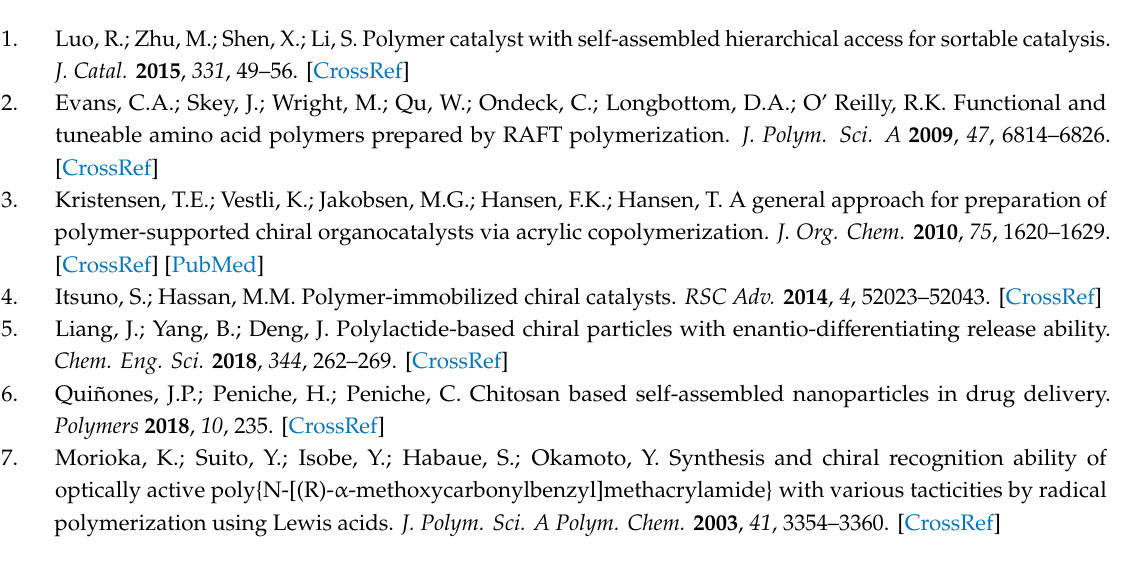
(penetration depth 1.66 mm). Figure S3: Phase behaviour of NaDC / water mixture as a function of pH and concentration. (cid:70) : transparent homogeneous liquid; (cid:78) : transparent homogeneous gel; (cid:4) : precipitate. Figure S4: Surface tension measurements of NaDC / water mixtures in 0.1 M NaCl, at pH 8.63 ± 0.47 and 24.7 ± 0.4 ◦ C (black dots) before and after the addition of 0.5 wt % L -ARGO7 (grey dots). The CMC value is the cross-point of the two linear segments. Figure S5: NaDC / water mixtures trend of ζ -values with pH. Panel (a) NaDC concentration between 0.05–1.0 mg mL − 1 ; panel (b) NaDC concentration between 2.5–5.0 mg mL − 1 . Data were collected in 0.1 M NaCl. Figure S6: pH-Dependence of the ζ -potential values of L -ARGO7 (black line), NaDC (grey line) and NaDC / water / L -ARGO7 mixtures (blue line) at NaDC concentrations higher than the CMC. L -ARGO7 concentration was 0.5 mg mL − 1 . Figure S7: Self-di ff usion coe ffi cients at pD 9 of: panel (a) NaDC in NaDC / water and NaDC in NaDC / water / L -ARGO7 systems; panel (b) L -ARGO7 in NaDC / water / L -ARGO7 systems. In both cases the L -ARGO7 concentration was 5 mg mL − 1 . For comparison purposes, in panel (b) the di ff usion coe ffi cient of plain L -ARGO7 in a 5 mg mL − 1 aqueous solution is also reported. Figure S8: Self-di ff usion coe ffi cients ( D s ) at pD 7 - 8 of: panel (a) NaDC / water and NaDC / water / L -ARGO7 systems; panel (b) L -ARGO7 in the same mixtures. In this case, for comparison purposes, also 5 mg mL − 1 D s of plain L -ARGO7 was reported (pale grey dotted line). Figure S9: CD spectra of 30 mg mL − 1 NaDC / water systems in 0.1 M NaCl and pH 7.30 as a function of time. Figure S10: Concentration-dependence of: panel (a) UV-vis and panel (b) CD spectra of NaDC / water systems, recorded at pD 9.06 in quartz-cell of 1 mm path length. Figure S11: NaDC scattering data as a function of concentration, at pD 7.3 - 7.5. Mathematical fittings were reported as red lines. Table S1: Hydrodynamic radii of NaDC before and after adding L -ARGO7 from DLS volume size distribution. Table S2: Concentration dependence of L -ARGO7 self-di ff usion coe ffi cients and hydrodynamic radii in the pD range 4.5–5.0. Table S3: pD-Dependence of the L -ARGO7 self-di ff usion coe ffi cients and hydrodynamic radii at concentration 10 mg mL − 1 . Table S4: Hydrodynamic radii of NaDC alone and in the presence of L -ARGO7, at pD 9.0, obtained from PGSE-NMR applying Stokes-Einstein equation (Equation (2)). Table S5: Hydrodynamic radii of NaDC alone and in the presence of L -ARGO7, at pD 7–8, obtained from PGSE-NMR applying Stokes–Einstein equation (Equation (2)). Table S6: Parameters obtained for NaDC / water using the hydrated ellipsoid mathematical model: scattering length density (SLD), polar and equatorial radii and charge. Standard deviation is lower than 1%, except where indicated otherwise. Table S7: Parameters obtained for 35 mg mL − 1 NaDC at pD 8.50–9.50 in the presence of 3.5, 35 or 70 mg mL − 1 D -ARGO7: scattering length density (SLD), polar and equatorial radii and charge. All values have a standard deviation lower than 1%, except where stated